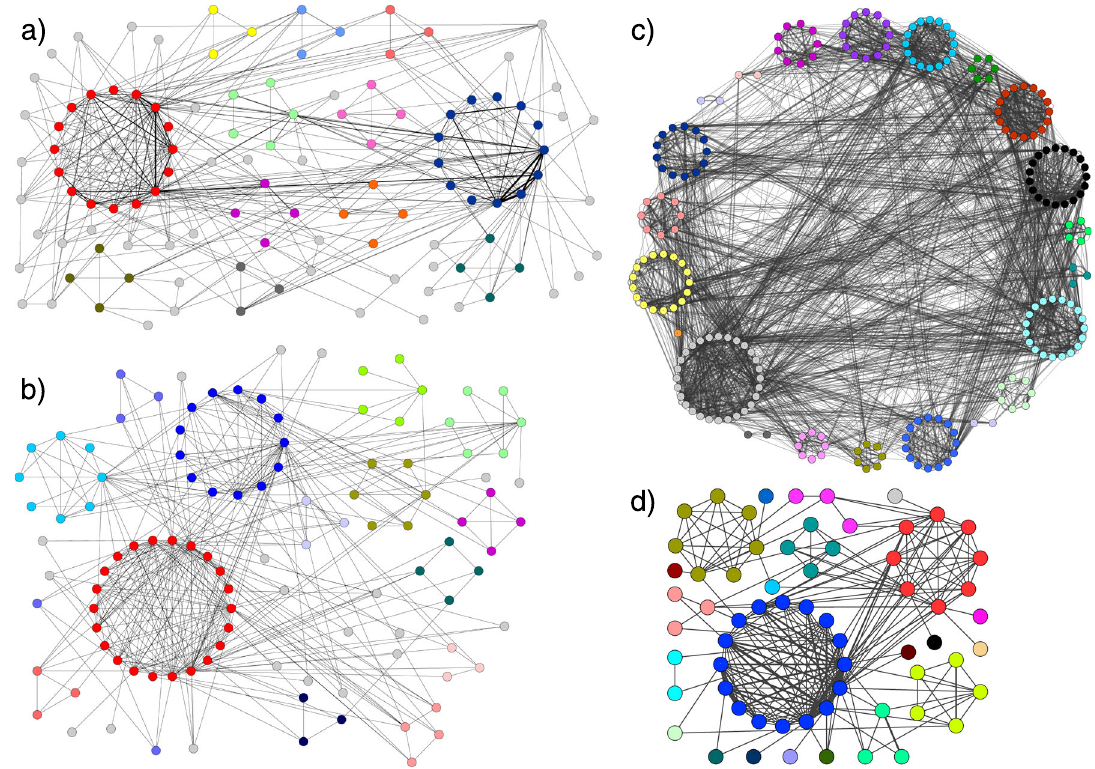
Fig. 8 Application of the surprise-based formalism for the detection of communities on real-world networks. Panels a and b show, respectively, the result of surprise minimization on the binary and the weighted version of the network of co-occurrences of Star Wars characters. Overall, link weights re fi ne the picture provided by just considering the presence of links: in the binary case, in fact, surprise detects two major clusters, induced by the characters of Episodes I-III and by the characters of Episodes IV-IX; once weights are taken into account, these clusters merge and give origin to the cluster of heroes of Episodes IV-IX. Panel c depicts the communities detected by minimizing surprise on the friendship network among the terrorists involved in the train bombing of Madrid in 2004 34 ; panel d depicts the communities detected by minimizing surprise on the friendship network among the residents living in an Australian University Campus 34